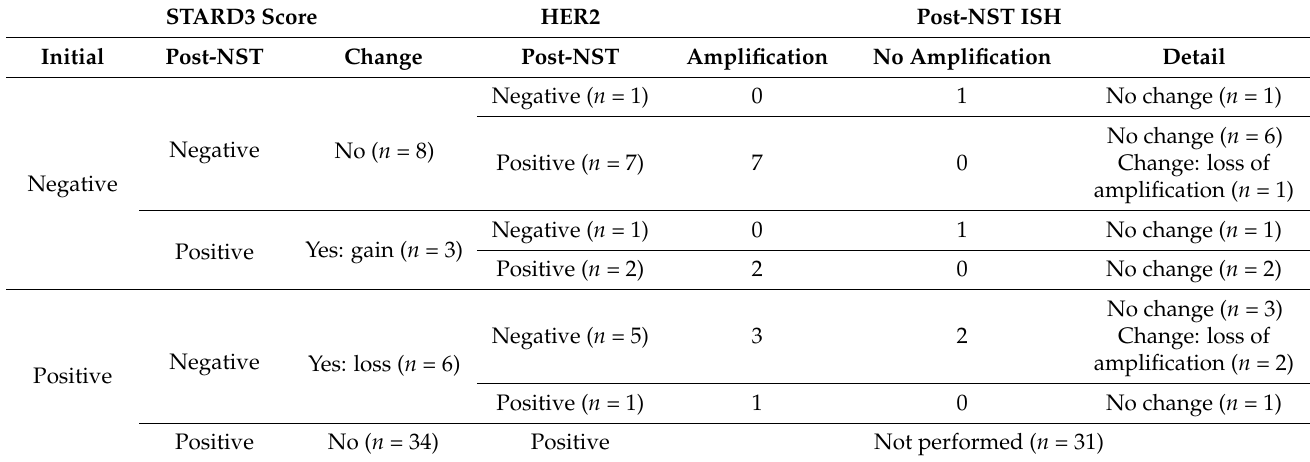
Table 3. STARD3 and HER2 expression after neoadjuvant systemic